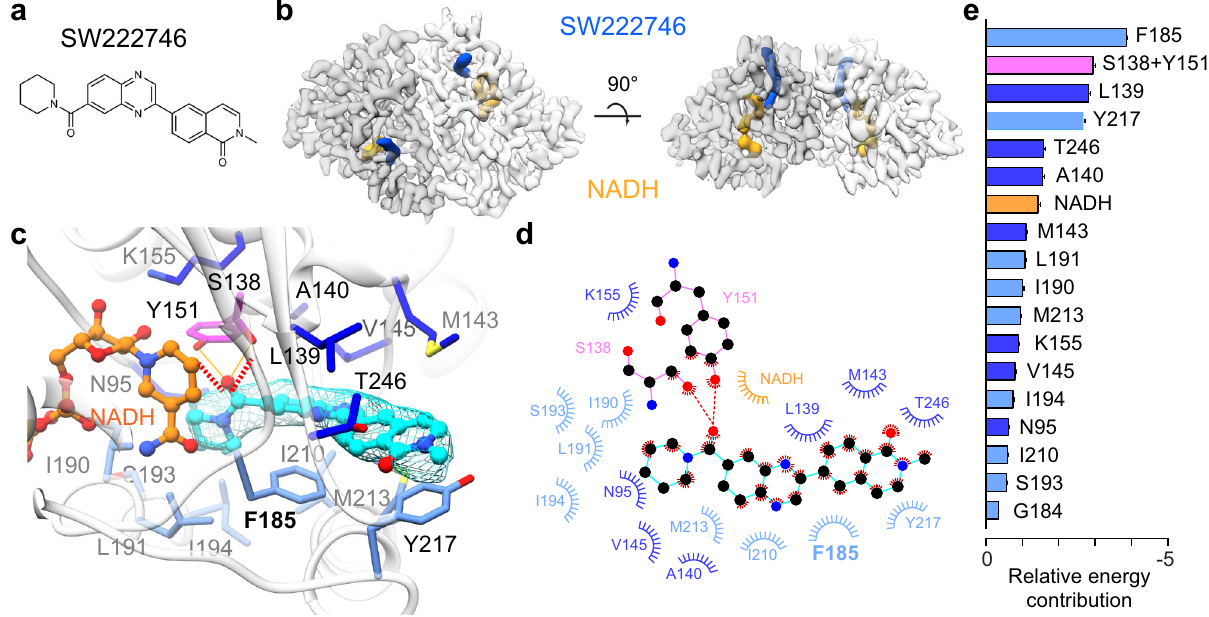
Fig. 4 | Cryo-EM structure of human 15-PGDH in complex with NADH and SW222746.a ThechemicalstructureofSW222746. b Thecryo-EMelectrondensity map of the 15-PGDH-NADH-SW222746 complex, with each protomer in the homodimeric assembly differentially colored. SW222746 and NADH are displayed inlightblueandorangerespectively. c Zoom-inviewofthedrugbindingpocketof SW222746 (cyan). Residues forming the drug-binding pocket are color-coded in three groups those in the catalyticcore(magenta), those around the catalyticcore